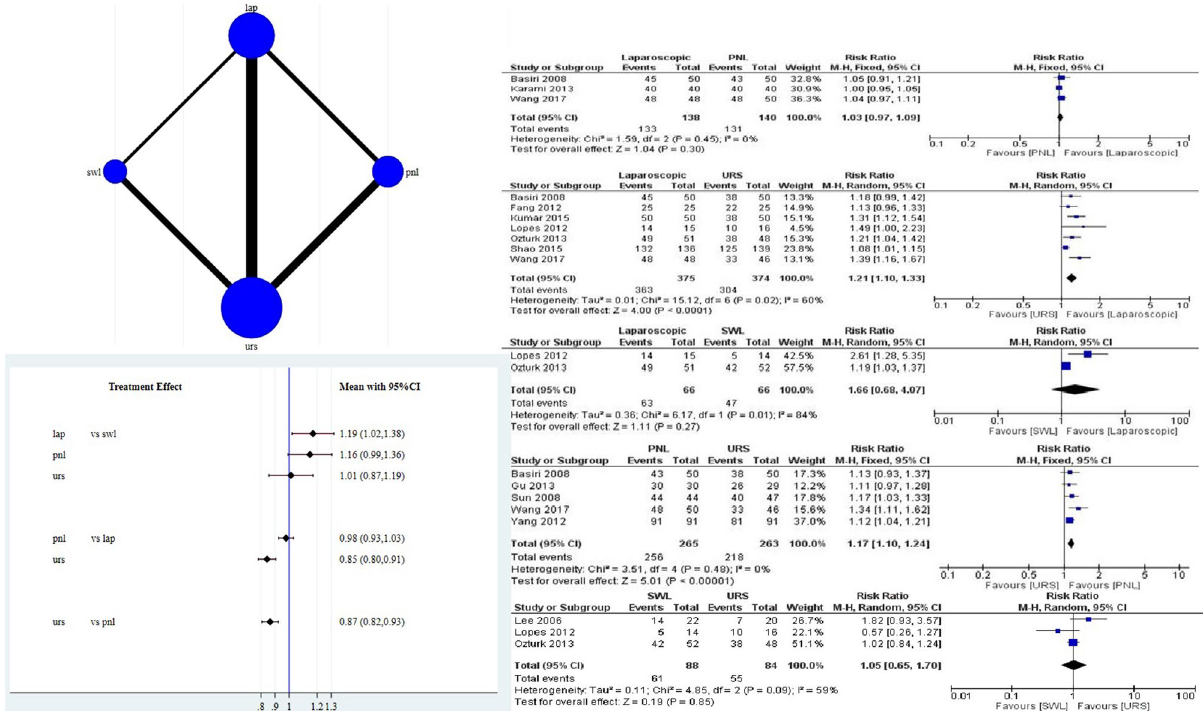
Figure 3. Depicts network map, interval plot and Forest plot for the final stone free rates.